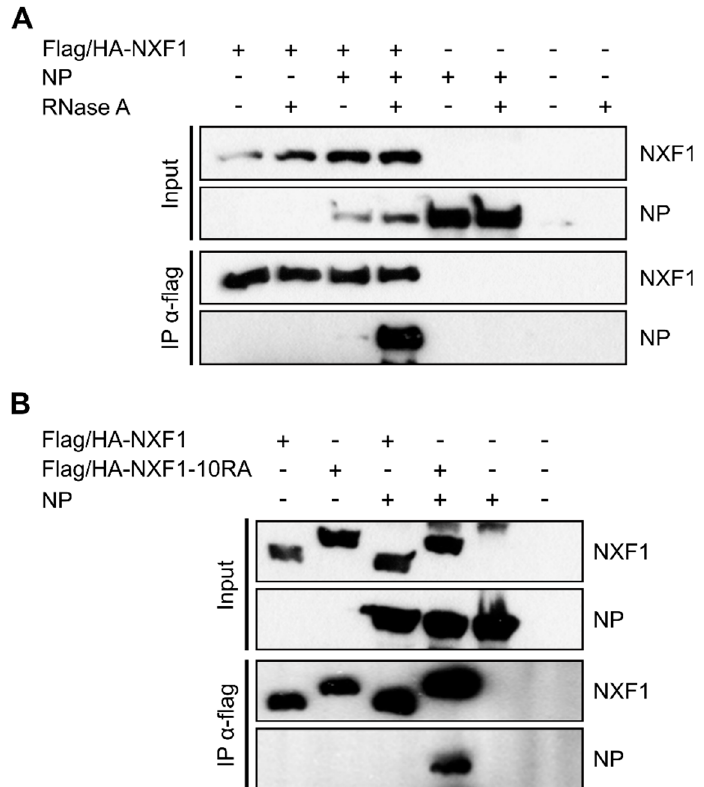
Figure 2. RNA dependence of the interaction between NXF1 and NP. ( A ) Absence of single-stranded RNA enhances interaction between NP and NXF1. 293T cell lysates containing overexpressed flag/HA-NXF1 and NP were treated with RNase A (100 µg/mL) or remained untreated before flag/HA-NXF1 was precipitated using anti-flag antibodies. Input and precipitates were analyzed via SDS-PAGE and Western blot using anti-flag and anti-NP antibodies. ( B ) RNA binding-deficient NXF1-10RA displays a stronger interaction with NP than wildtype NXF1. 293T cells were transfected with plasmids encoding for either flag/HA-NXF1 or flag/HA-NXF1-10RA together with NP, and 48 h p.t. cells were lysed and subjected to coIP analyses. Pulldowns were performed using anti-flag antibodies, and precipitates as well as input samples were analyzed via SDS-PAGE and Western blot using anti-flag and anti-NP antibodies.